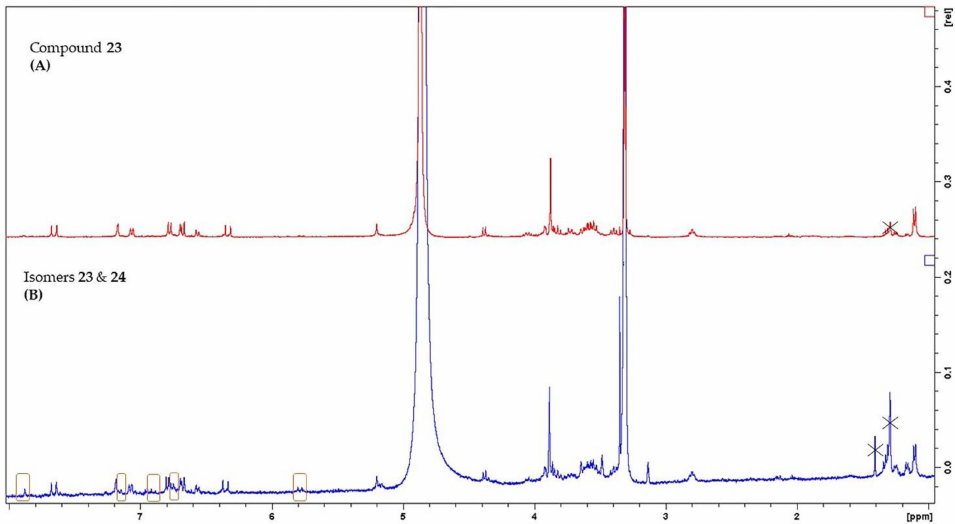
Figure 3. 1 H-NMR spectra of leucosceptoside A isomers. ( A ) 1 H-NMR spectrum of trans - leucosceptoside A (compound 23 ), ( B ) 1 H-NMR spectrum of the mixture of trans -leucosceptoside A (compound 23 ) and cis - leucosceptoside A (compound 24 ). The major points of differences of the two isomers were signed in orange